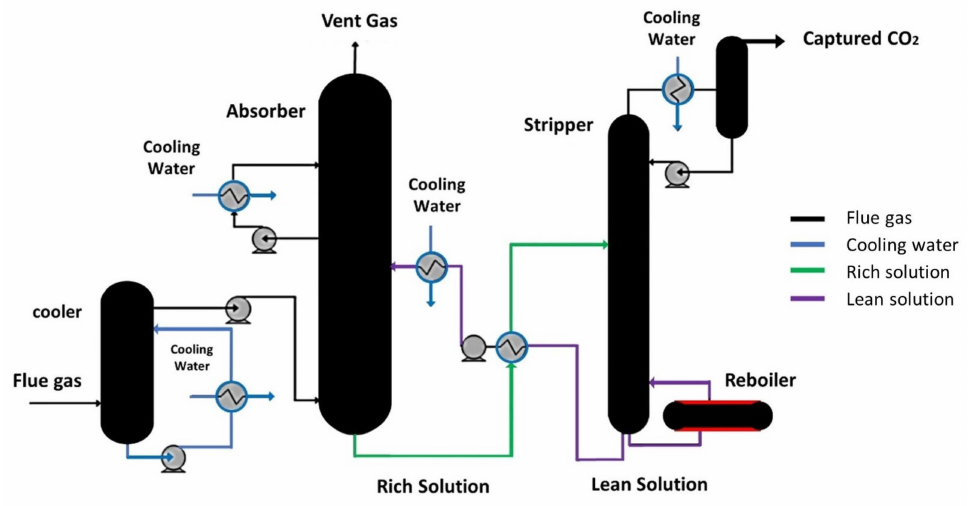
Figure 4. Amine scrubbing unit.